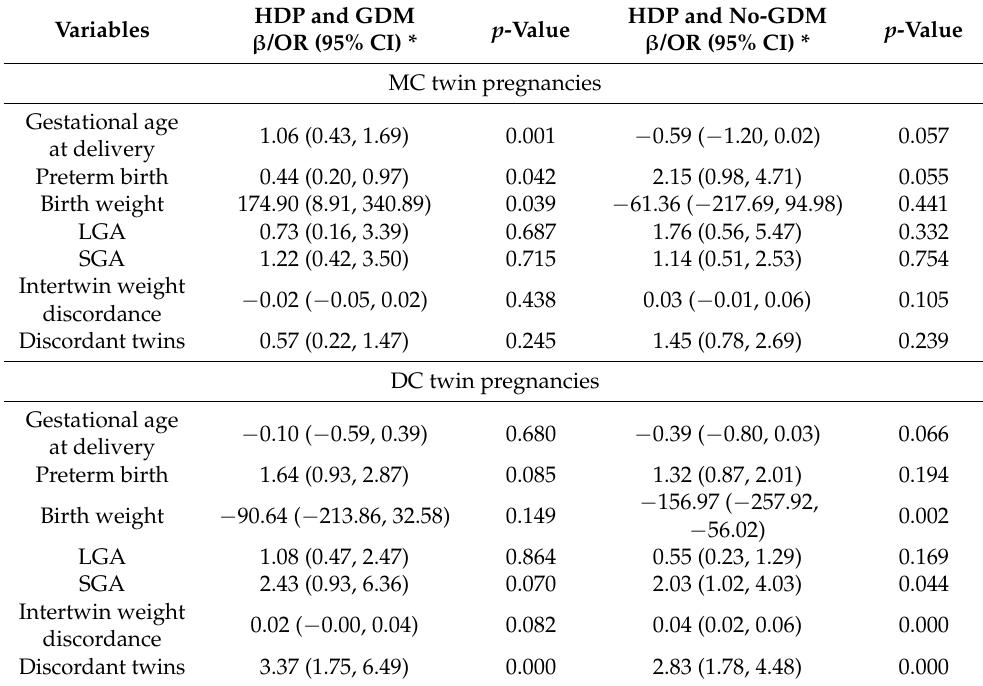
Table 4. Association between HDP-twin pregnancies with or without GDM and neonatal outcomes in twin